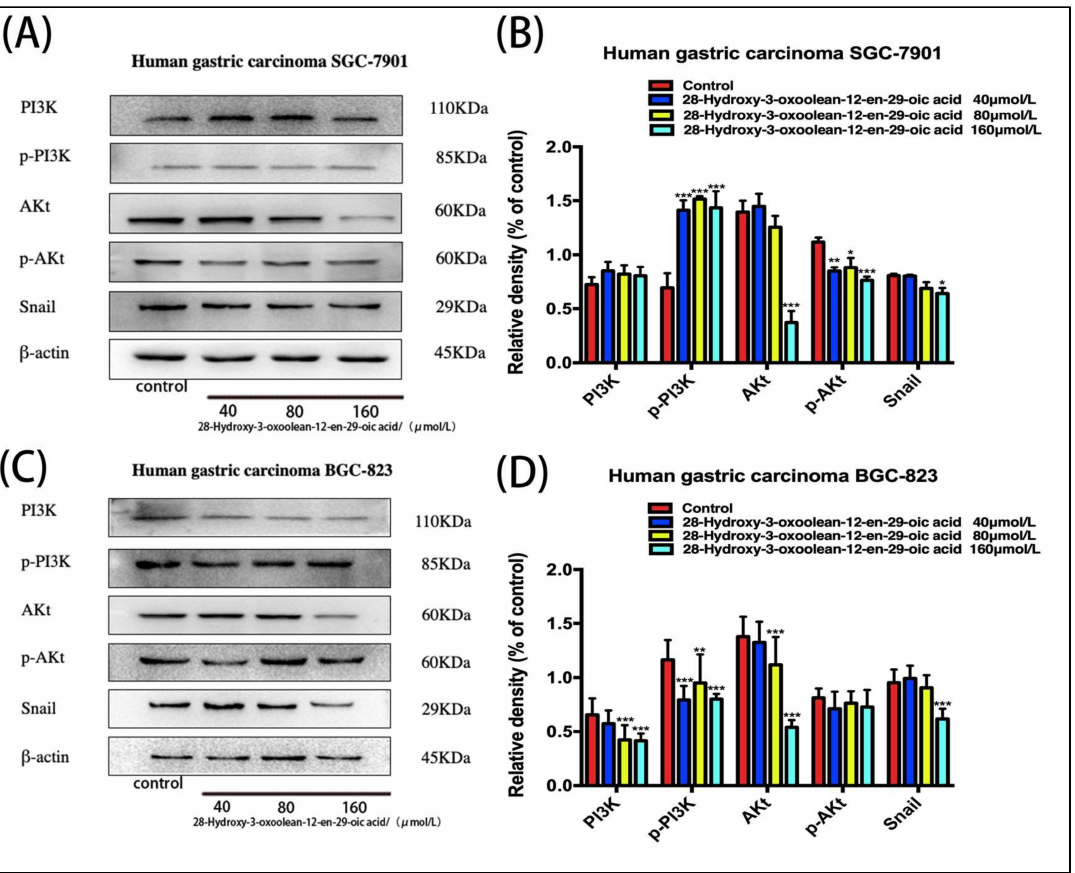
Figure 7. ( A , C ) Changes in PI3K / AKt / Snail biomarker expression levels following treatment with 28-hydroxy-3-oxoolean-12-en-29-oic acid for 24 h were assessed by Western blotting. ( B , D ) The band intensities of AKt, (p)-Akt, PI3K, (p)-PI3K and Snail relative to untreated control cells were quantified upon normalizing to β -actin expression, and are expressed as the mean ± standard deviation of three independent